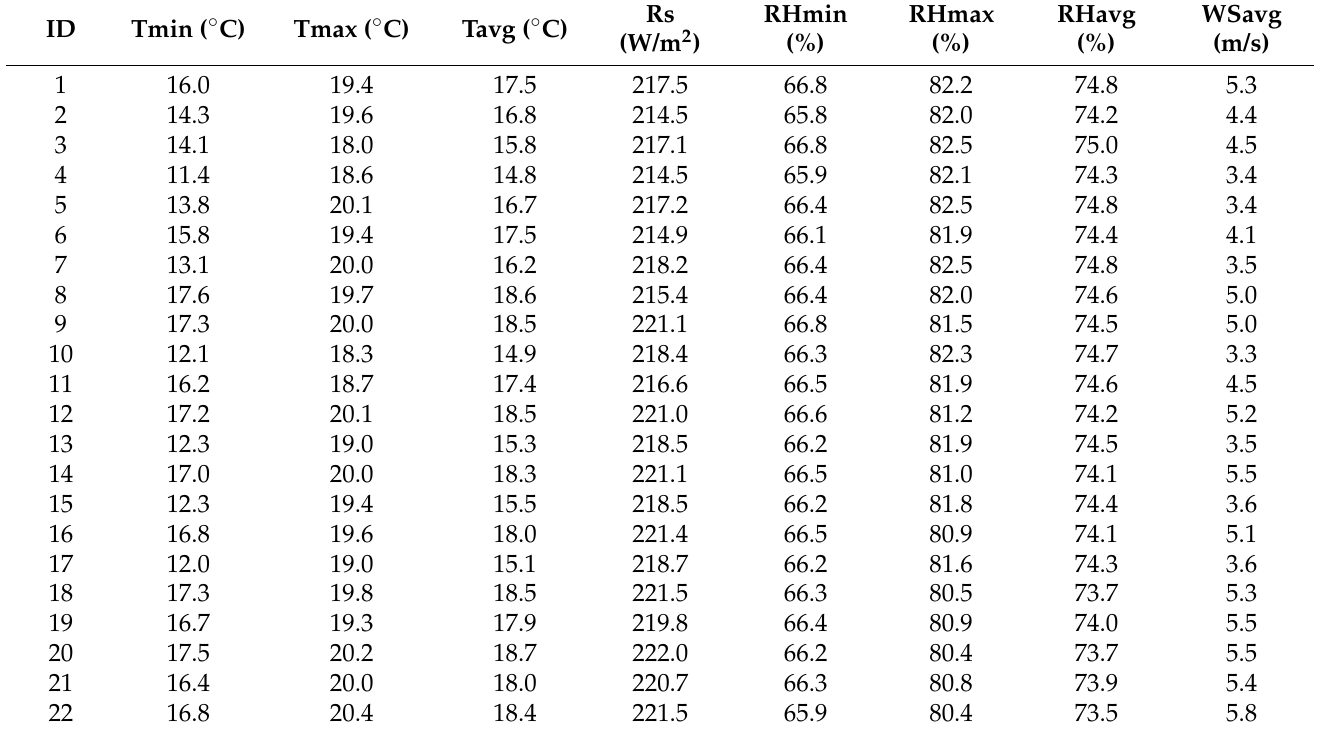
Table 1. Monthly values for Temperature (minimum, maximum and average) Relative Humidity (maximum, minimum and average), Wind Speed (average) and Solar Radiation (1999–2014).